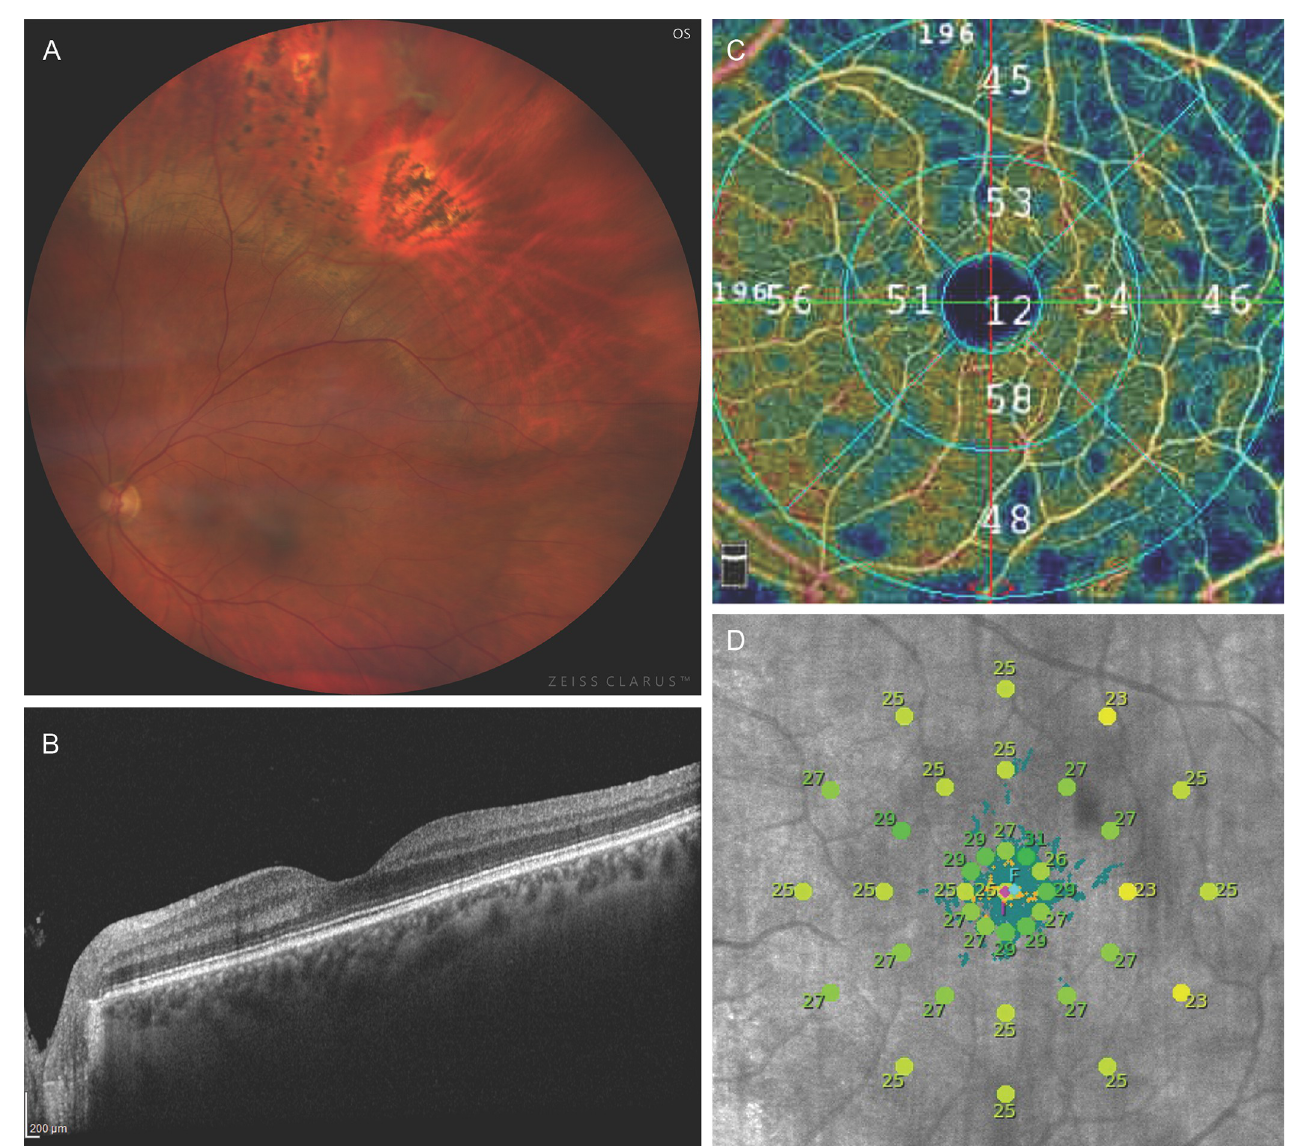
Fig 1. Left eye imaging results of a 57-year-old woman after scleral buckling for macula-on rhegmatogenous retinal detachment. A) Retinography showing the placement of the buckle, which was done such that the break would fall on the posterior 1/3 of the buckle; B) Spectral-domain optical coherence tomography demonstrating normal structure of the retina in the macula; C) Optical coherence tomography angiography presenting the vascular density in the superficial vascular plexus; D) Microperimetry result showing sensitivity of the retina around ± 5˚ of the macula. automatic measurement of the vessel density in these plexuses as well as the analysis of the sur- face area in the foveal avascular zone in the macular area. VD was calculated as the percentage of area occupied by flowing blood vessels in the selected region. For ONH scans, VD was ana- lyzed in the peripapillary area, which extends outwards from the ONH border with an elliptical area between 2–4 mm. The RPC layer was defined as extending from the inner limiting mem- brane (ILM) to the posterior border of the RNFL. In the macula, analyses of vessel density were performed on the entire surface of 6 × 6 mm 2 en face images. The SVP comprised the area between the ILM and the outer boundary of the inner plexiform layer (IPL), while the